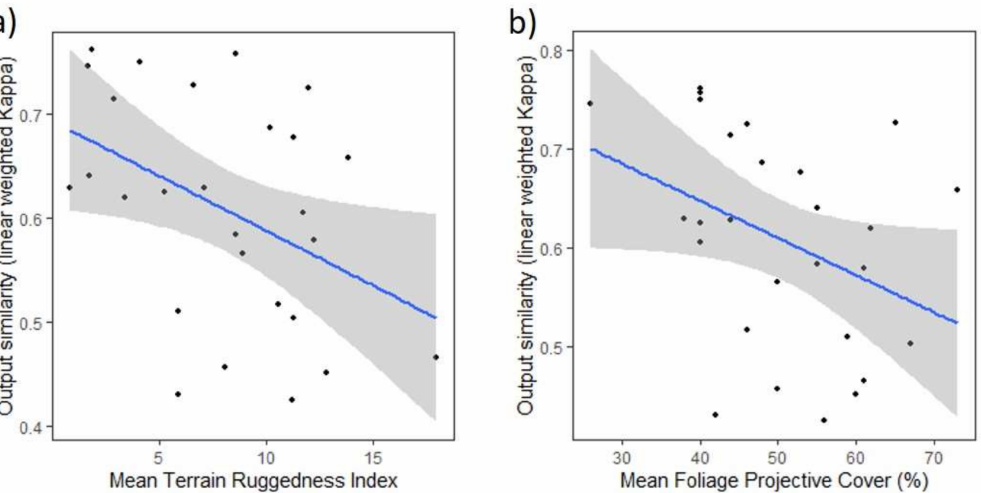
Figure 7. Relationships between Sentinel 2 and Landsat 8 output similarity (linear weighted Kappa score) for study fires and the mean Terrain Ruggedness Index ( a ) and mean foliage projective cover ( b ) of the fire area. Note that TRI values close to 1 denote flat areas, while higher values denote increasingly rugged